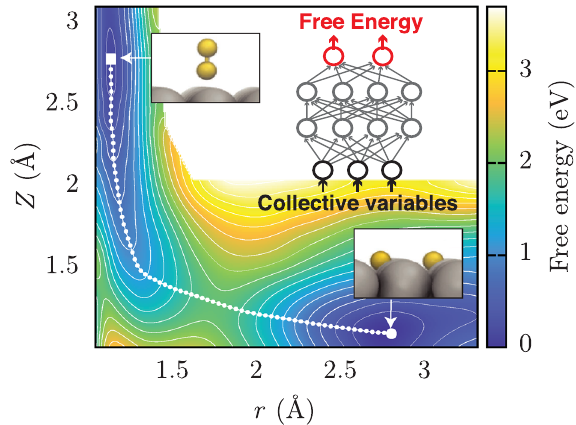
Fig. 3 Free energy landscape of a heterogeneous catalytic reaction. Free energy surface (FES) for nitrogen dissociation on ruthenium computed from CFF 77 — FPMD simulations using 16 walkers 33 . The axes correspond to the distance Z from the surface and the separation r between the nitrogen atoms, in Angstrom. The converged FES shown here corresponds to the stage reached after 33 ps of FPMD. The mean free energy path between N 2* (square) and 2 N * (circle) is represented by a white dashed line. Adapted with permission from ref. 33 under the Creative Commons Attribution License CC BY 4.0.